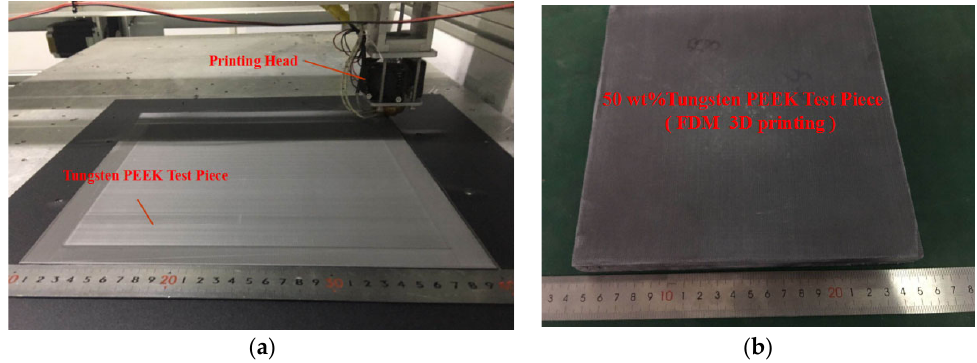
Figure 9. Processing of an FDM 3D printed shielding test piece: ( a ) during production and ( b ) after production.